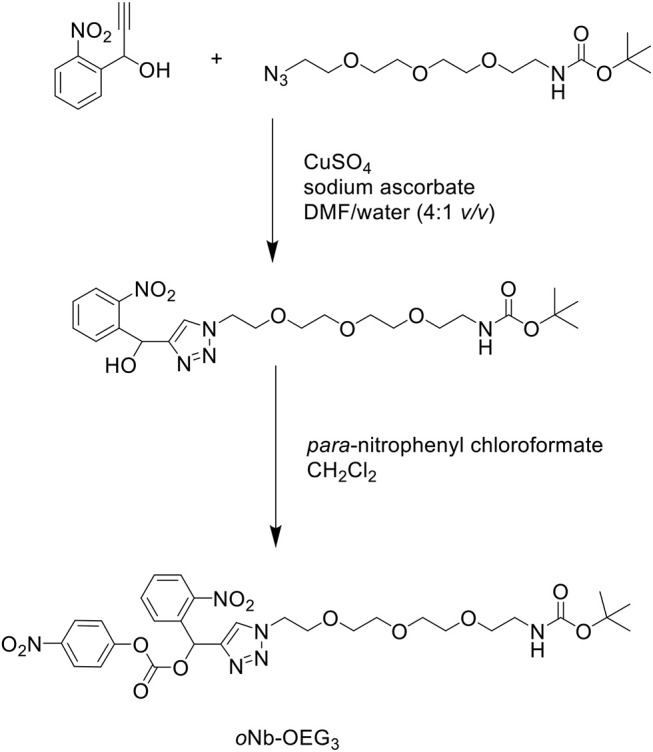
Synthesis of oNb-OEG3 solubilizing tag for Aβ1−42.